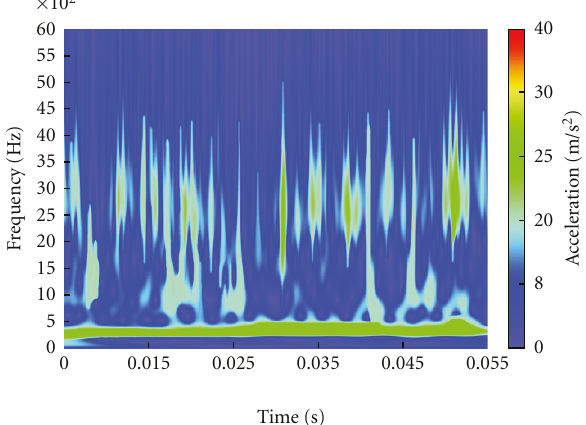
Figure 4: Frequency scalogram of square wavelet coe ffi cient of the reference gear